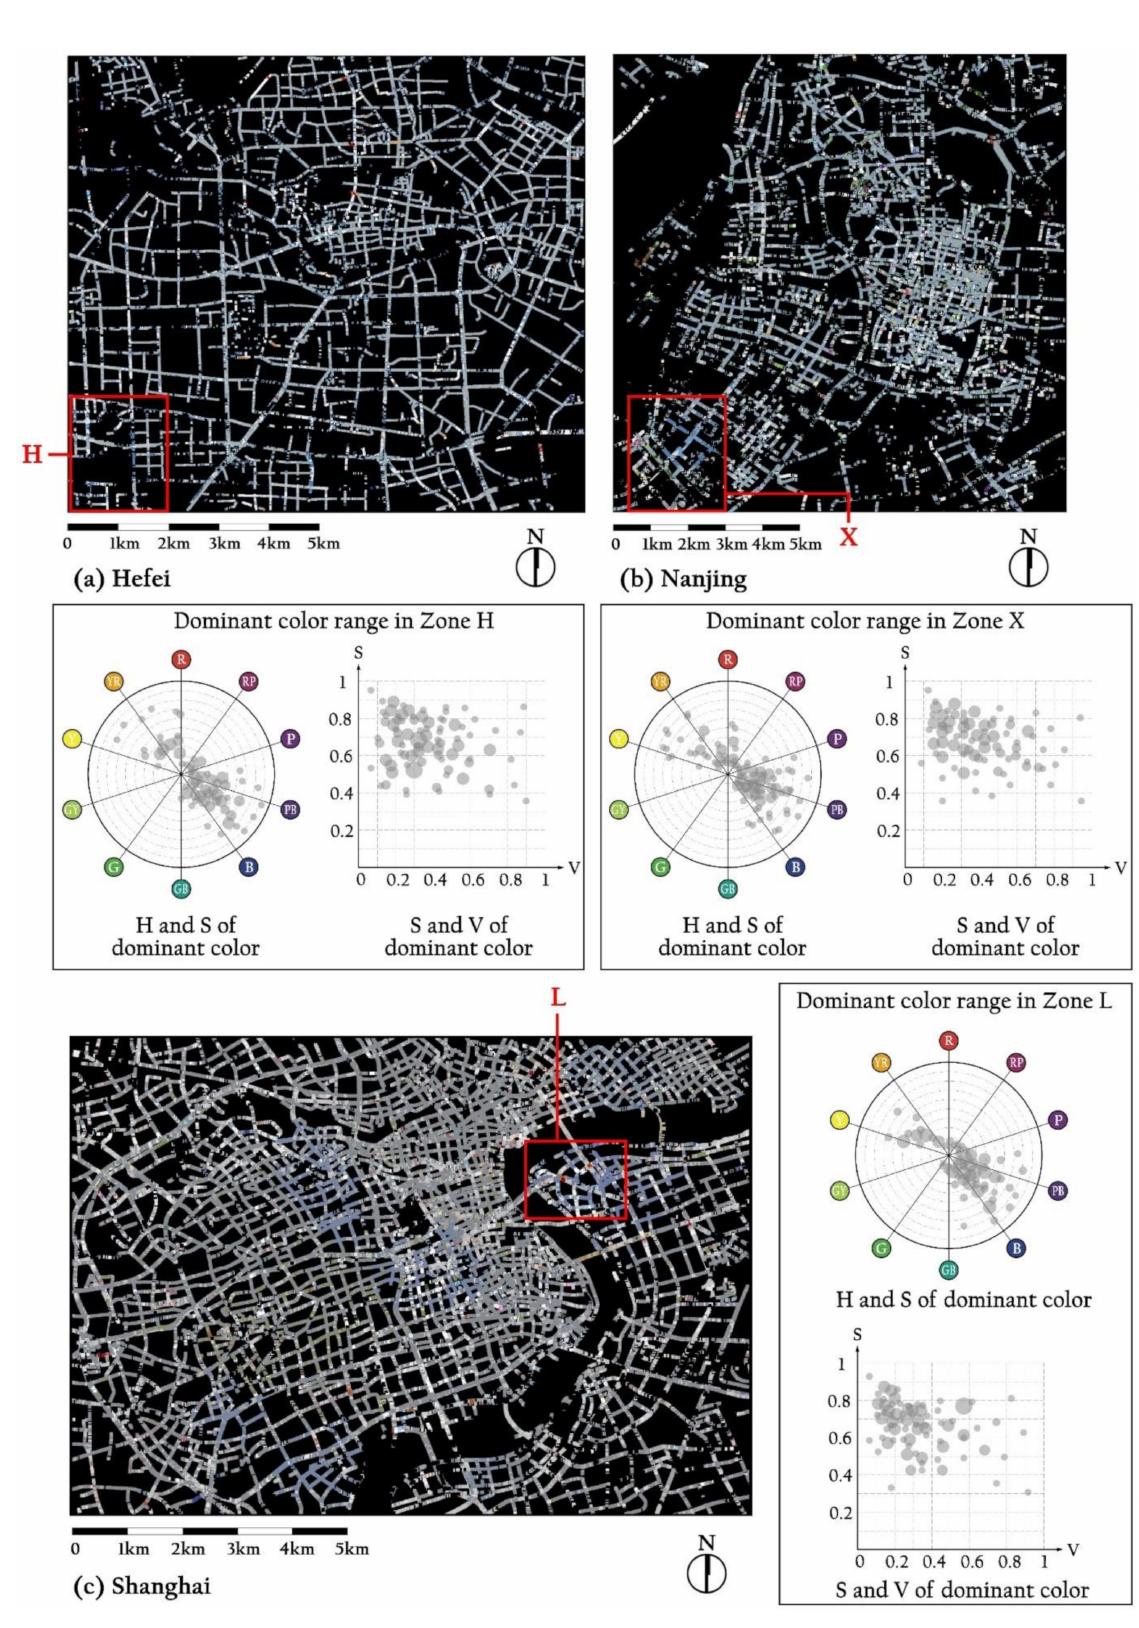
Figure 13. Mapping the dominant color of the building façade of Hefei, Nanjing, and